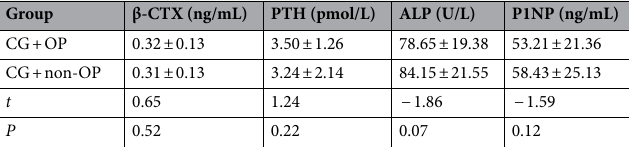
Table 2. Comparison of biochemical markers between two